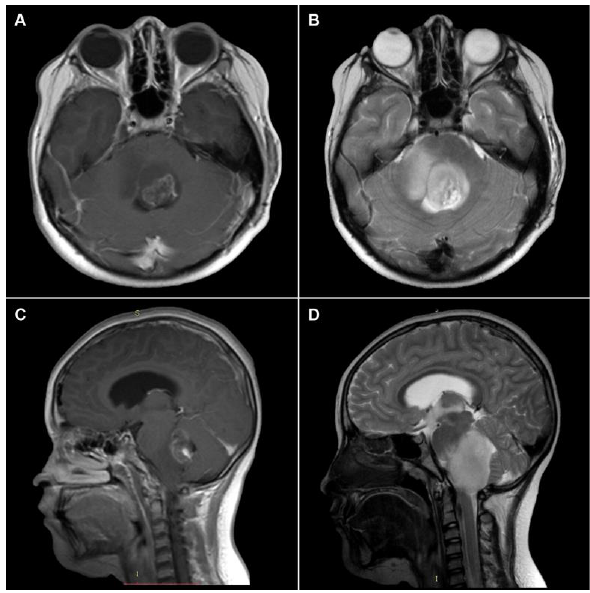
Figure 2. The axial and sagittal planes show the MRI appearance of DMG on T1- and T2-weighted images. ( A , C ) Images show contrast-enhanced tumoural lesions, but ( B , D ) images showed extensive oedema tumoural and diffuse/infiltrative patterns.